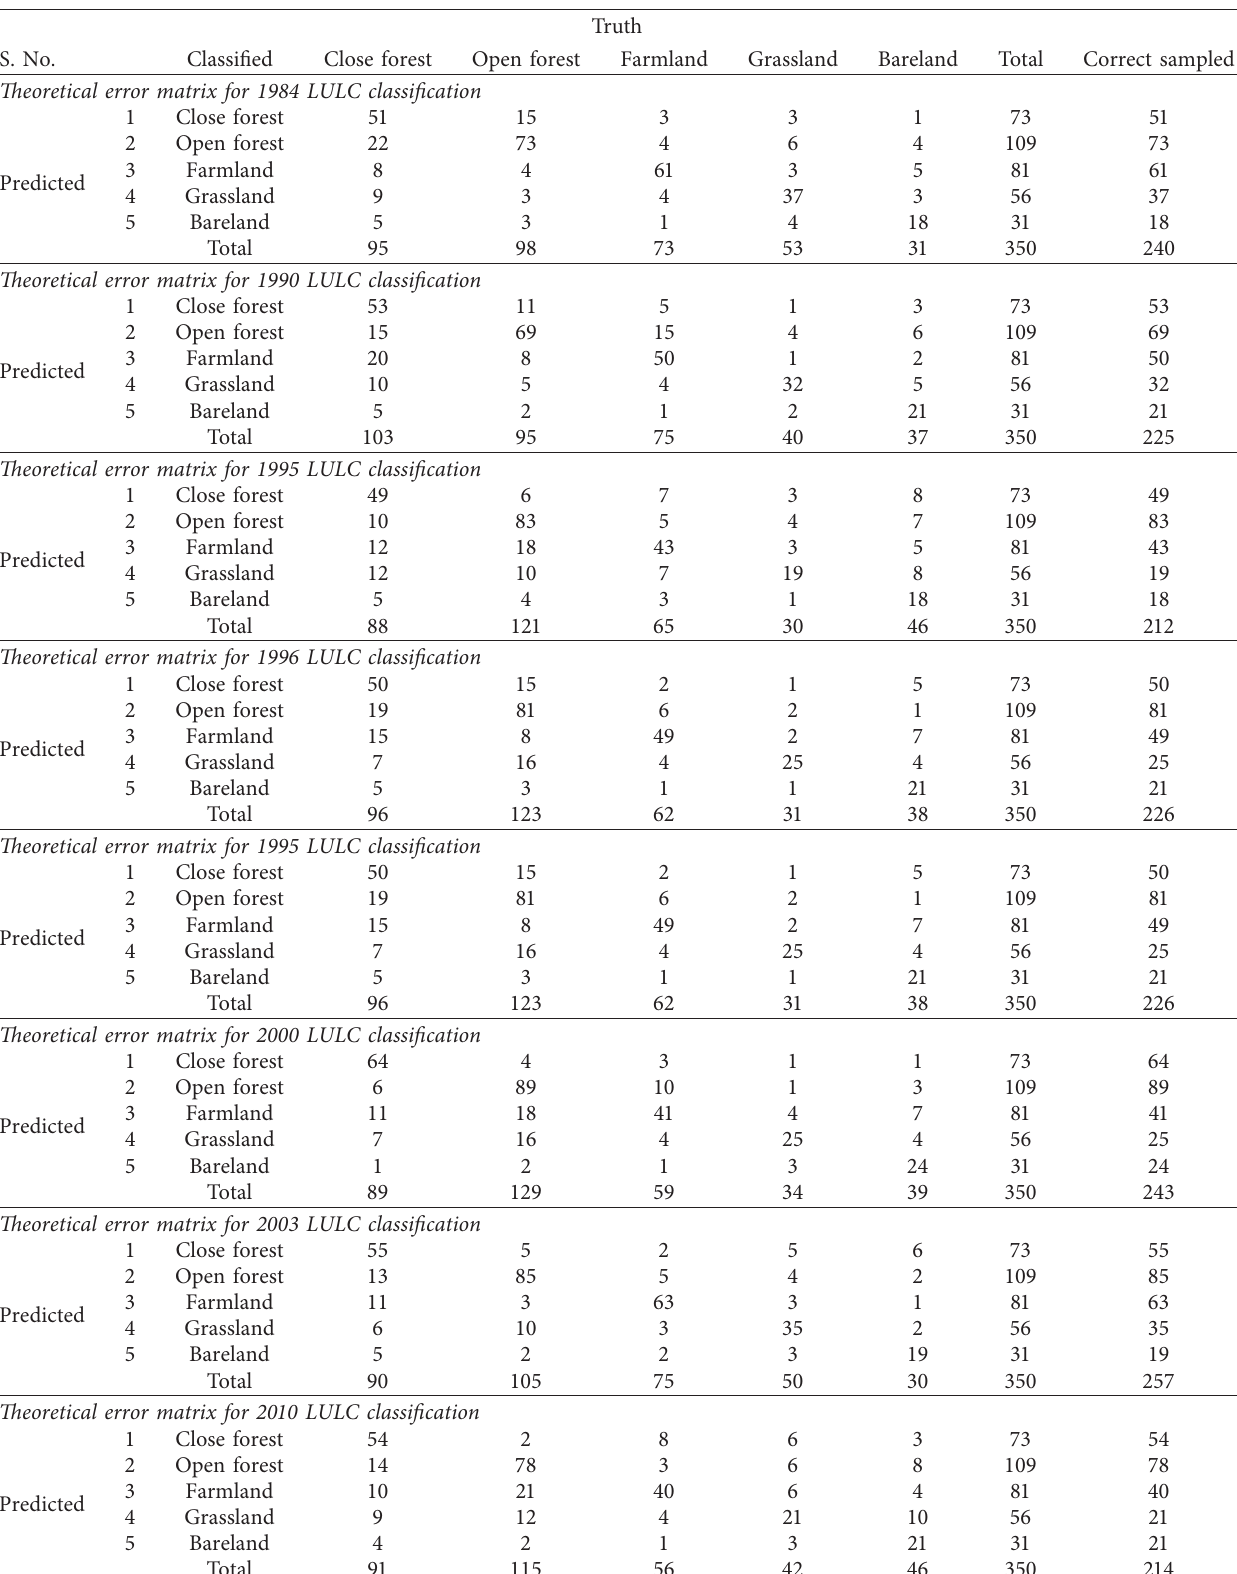
Table 5: Error matrix report tables for LULC